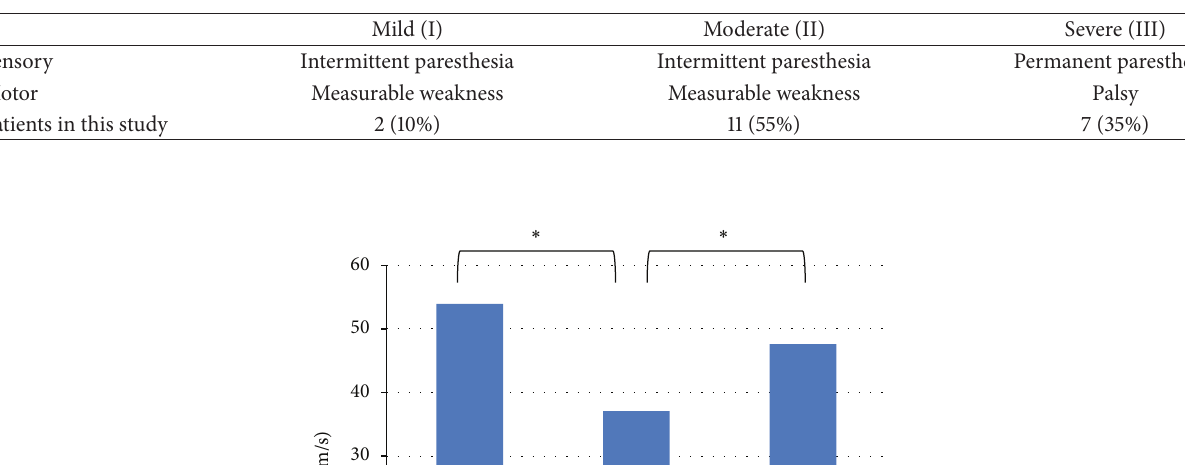
Table 2: Dellon’s classification.